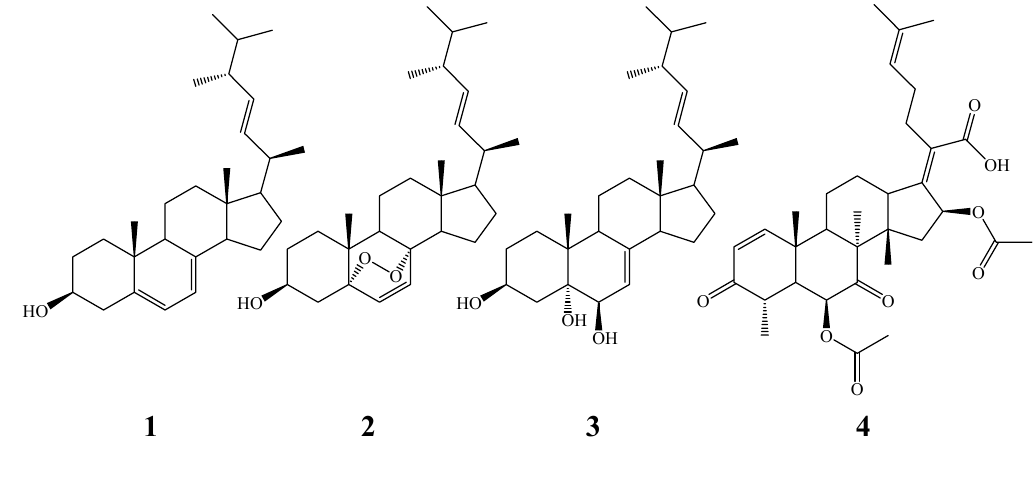
Figure 1. Chemical structures of the compounds ergosta-5,7,22-trienol ( 1 ), 5 α ,8 α -epidi- oxyergosta-6,22-dien-3 β -ol ( 2 ), ergosta-7,22-dien-3 β ,5 α ,6 β -triol ( 3 ) and helvolic acid ( 4 )